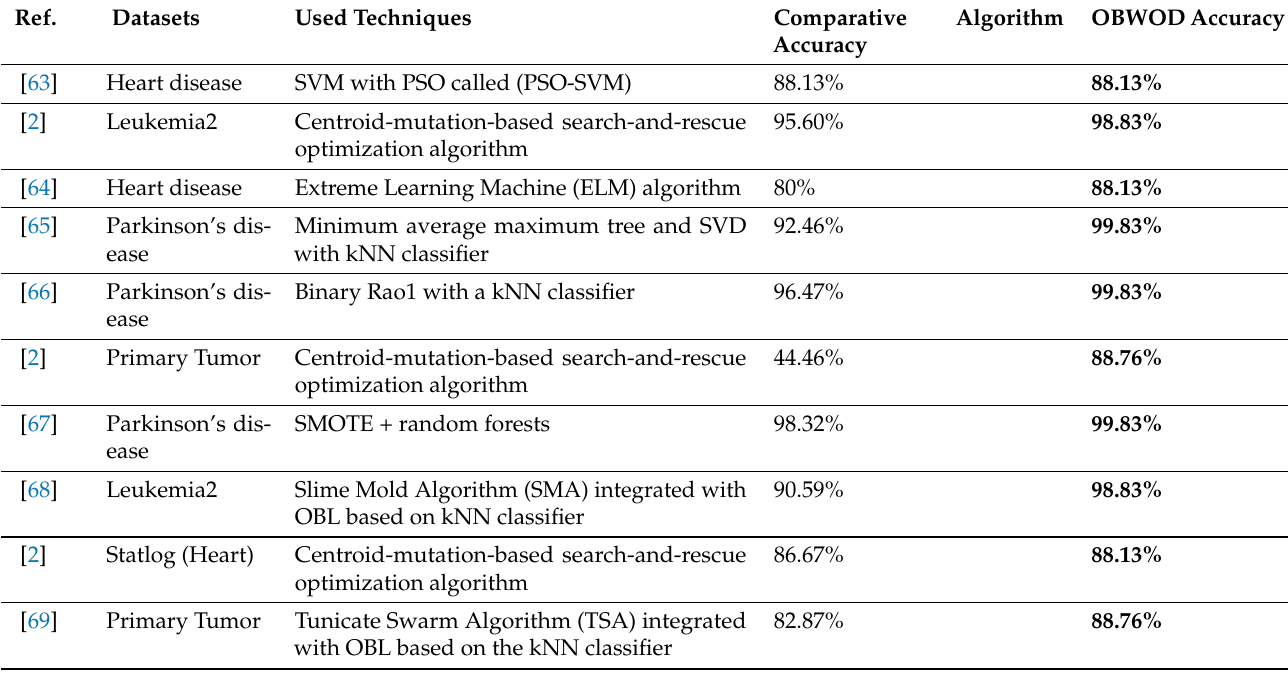
Table 14. Comparison of OBWOD and MH algorithms on biomedical